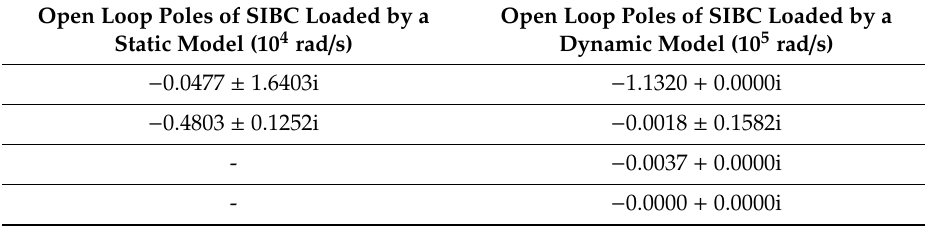
Figure 9. Comparison of different voltage profiles obtained at the terminals of the PEM-EL. Table 4. Comparison of the poles of the open loop system with static and dynamic models of the load